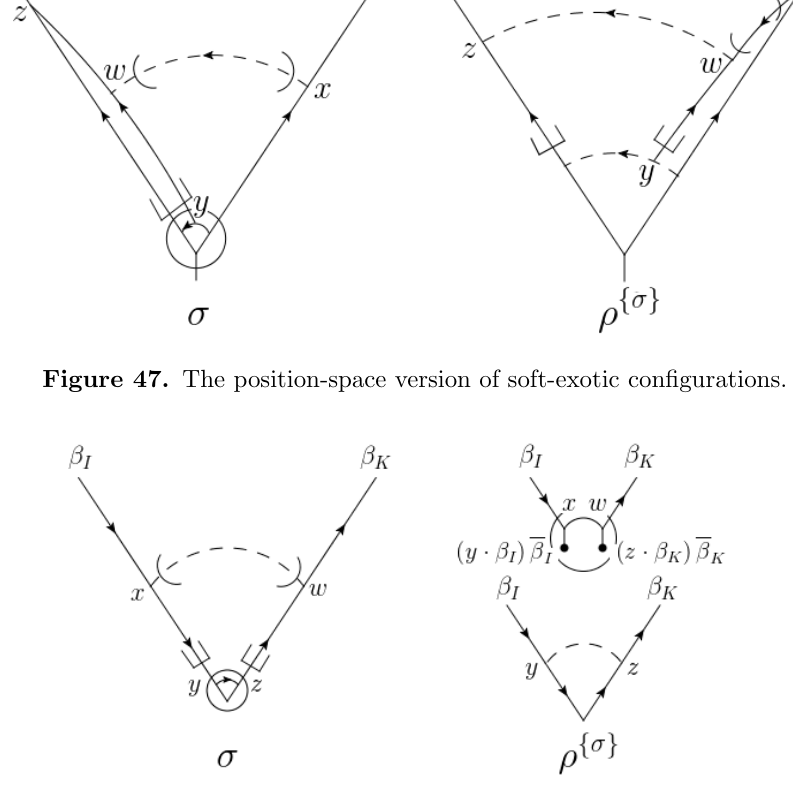
Figure 48. The position-space version of hard-exotic